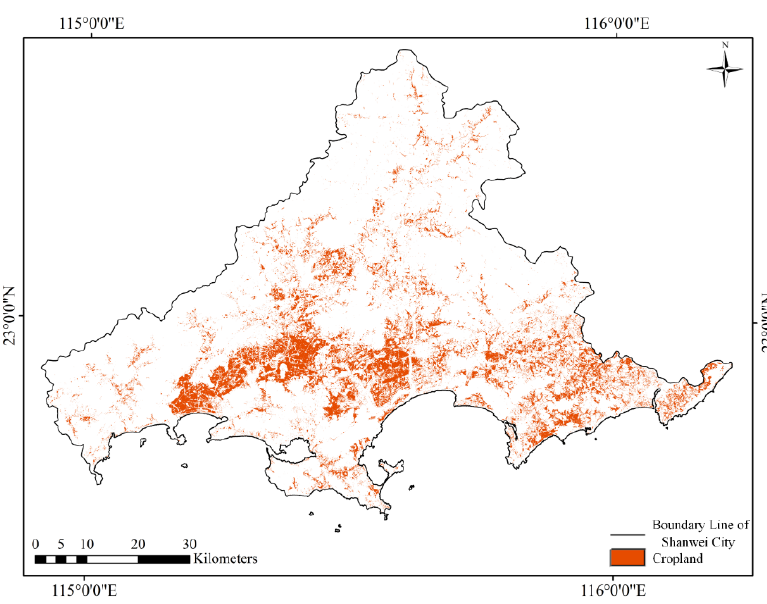
Figure 10. Rice map of Shanwei cityin 2019.